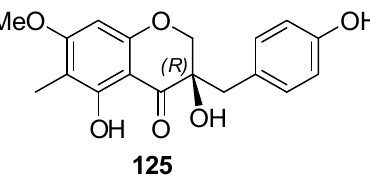
Figure 20. Chemical structure of compound 125 isolated from S. roxburghiana.